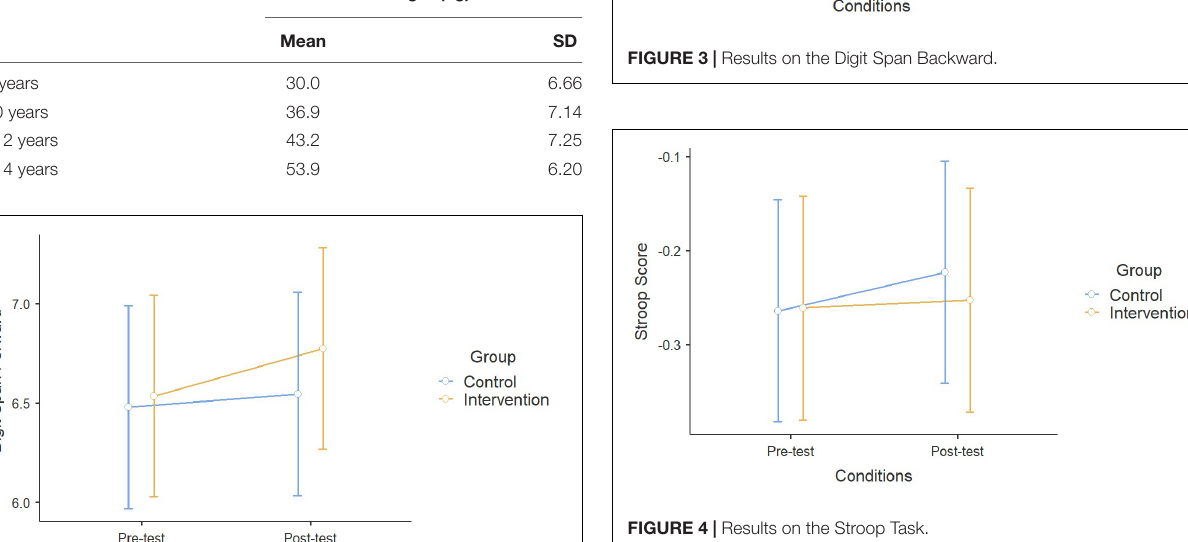
FIGURE 4 | Results on the Stroop Task.